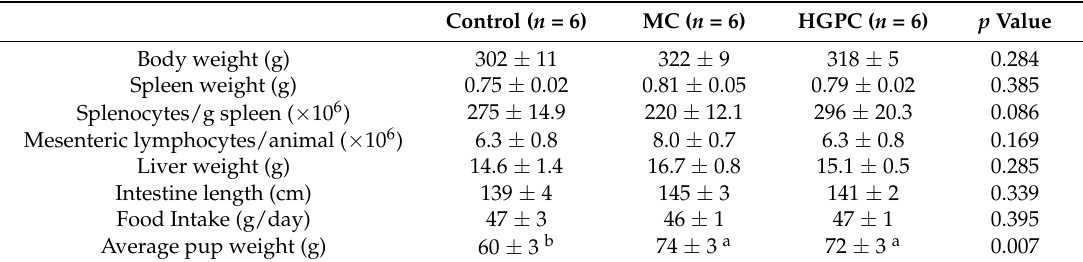
Table 2. Anthropometric data of lactating dams fed Control (100% FC), Mixed Choline (MC; 50%